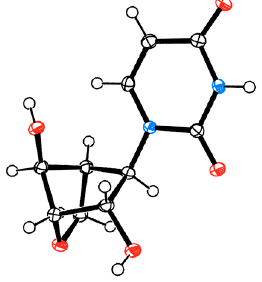
Figure 3. ORTEP drawing of the X-ray crystal structure of 12 (thermal ellipsoids at the 50% probability level).